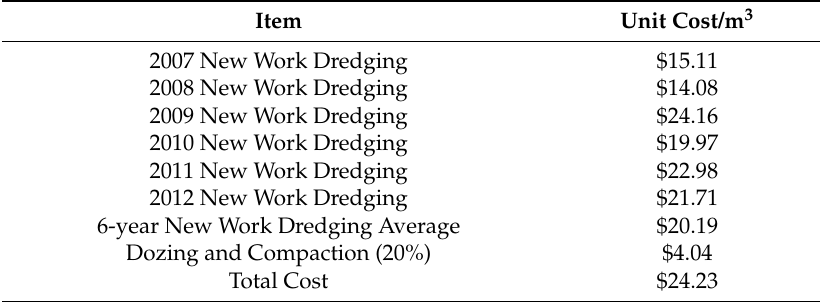
Table 1. Average cost of overland fill to elevate land areas (2012 US dollars). Six years of cost for new work dredging (clean dredge material) are averaged and multiplied by a dozing and compaction factor of 20% to estimate the unit cost of adding fill to elevate land areas